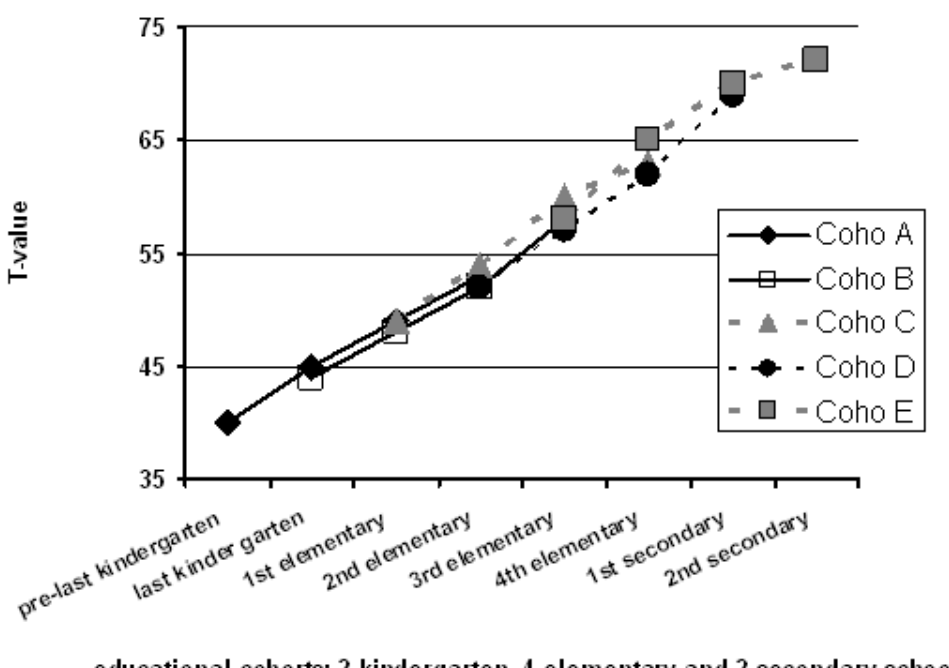
Figure 7. Cross-sequential results on general intelligence in the German